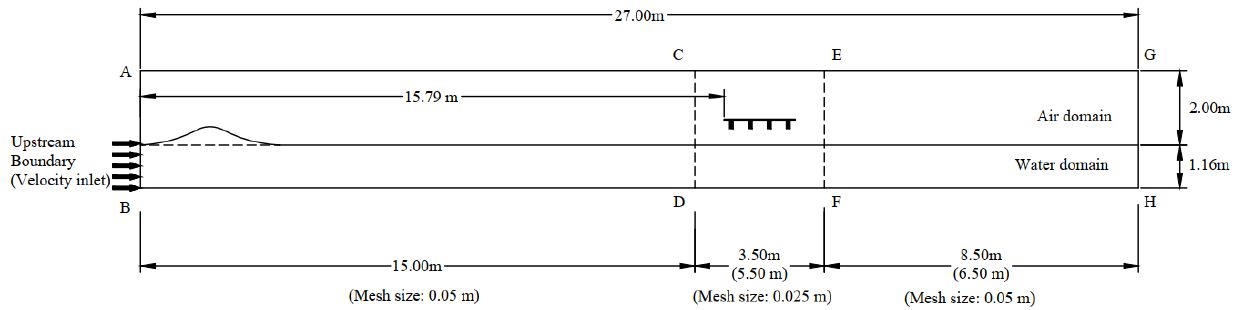
Figure 1. Layout of the computational domain.